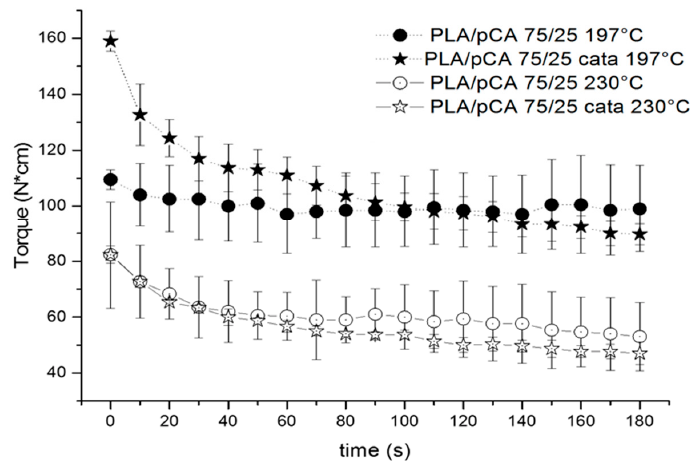
Figure 1. Trends of torque as a function of time recorded for PLA/pCA blends prepared at 230 °C and 197 °C with or without TBATPB. N*cm= N·cm.